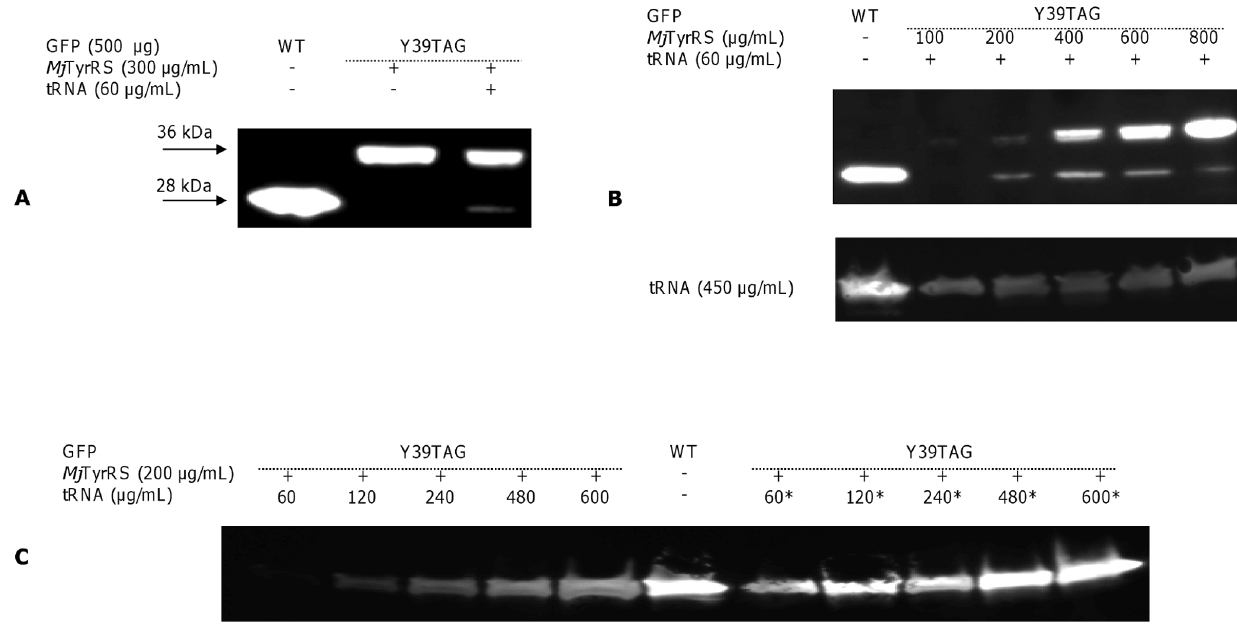
Figure 2. Western Blot of WT GFP and GFP Y39TAG mutant expression in a cell-free translation system. Synthesis of WT GFP and the GFP Y39TAG mutant was performed using the RTS E. coli HY Kit, to which the corresponding plasmid (500 m g/mL), purified Mj TyrRS and cognate suppressor Mj tRNA CUA (tRNA) or T-stem modified tRNA CUAOpt (denoted as *) were added. (A) Expression of WT GFP and the GFP Y39TAG mutant in the presence of Mj TyrRS (300 m g/mL) and synthetic Mj tRNA CUA (60 m g/mL). The band at 28 kDa corresponds to full-length GFP. (B) Western blot analysis demonstrates enhanced GFP Y39TAG protein expression as a function of increased Mj TyrRS concentrations in a cell-free reaction medium supplied with Mj tRNA CUA (60 m g/mL – top panel and 450 m g/mL – bottom panel). ( C ) Dependence of GFP Y39TAG yield on the type and concentration of nonsense suppressor, as visualized by Western blot.